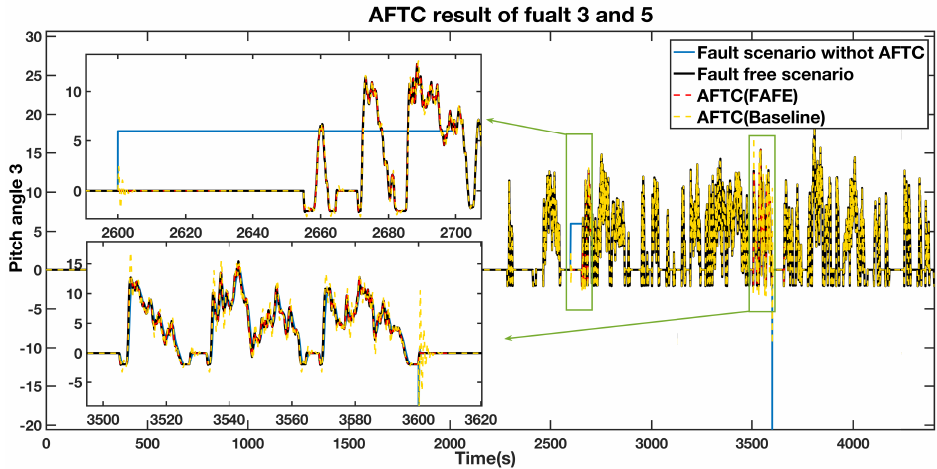
Figure 8. AFTC Results Comparison of the pitch angle 3 output.